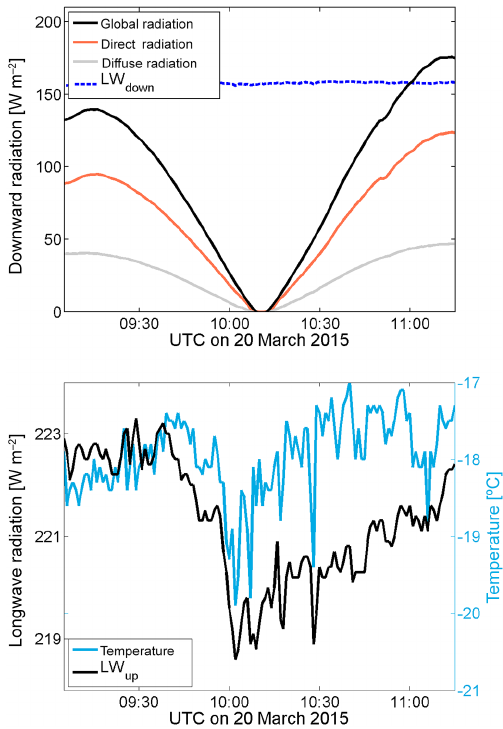
Figure 5. The downward radiation components’ shortwave direct, diffuse, and global radiation as well as downward thermal radia- tion (upper panel), and the upward thermal radiation LW up and 2m temperature (lower panel) between 09:10 and 11:10UTC on 20 March 2015 in Ny-Ålesund.